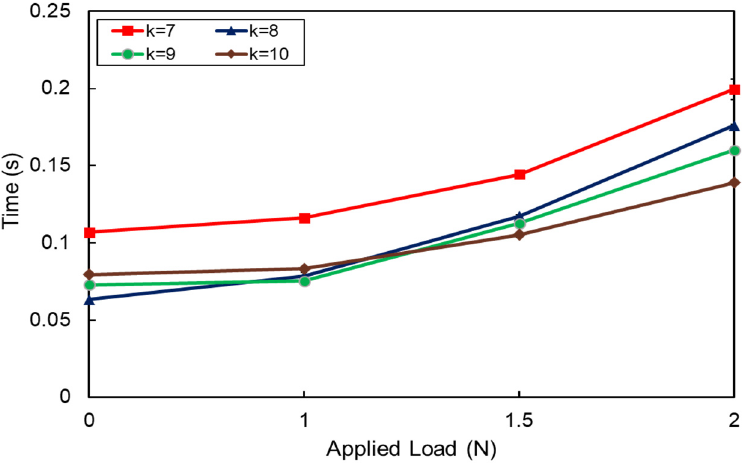
Figure 10. Time required to reach a target point at a distance of 3 mm for various gain values and vertical forces.